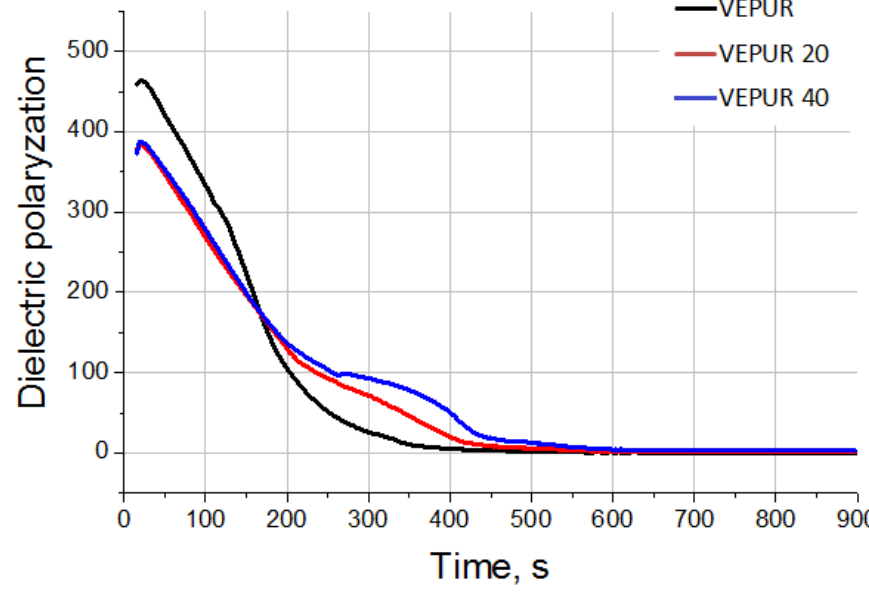
Figure 5. Dielectric polarization changes depending on the filler content in the polyurethane formulation.